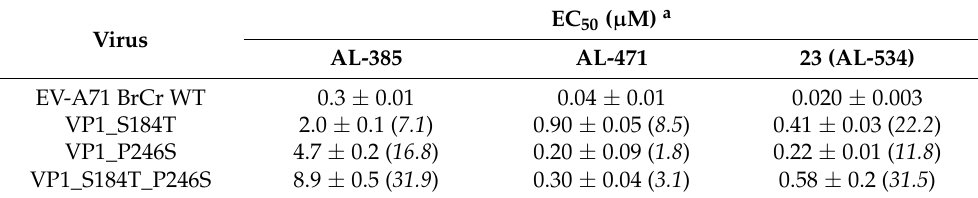
Table 5. Cross-resistance data and resilience of 23 ( AL-534 ) to mutations in VP1.